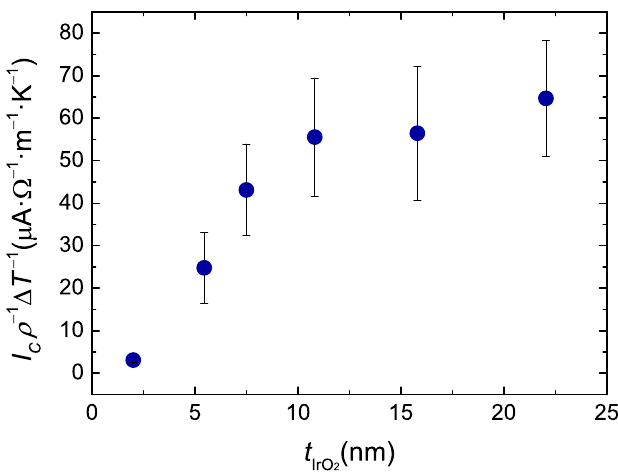
Figure 4. Evolution of I c / ( ρ c ∆ T ) with the thickness of IrO 2